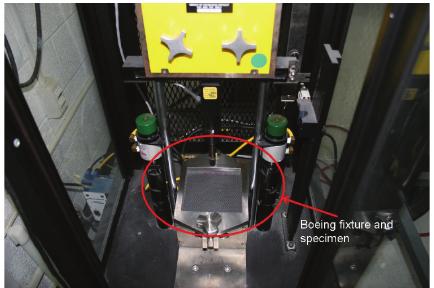
Figure 5: Test coupon clamped in the Boeing fixture.